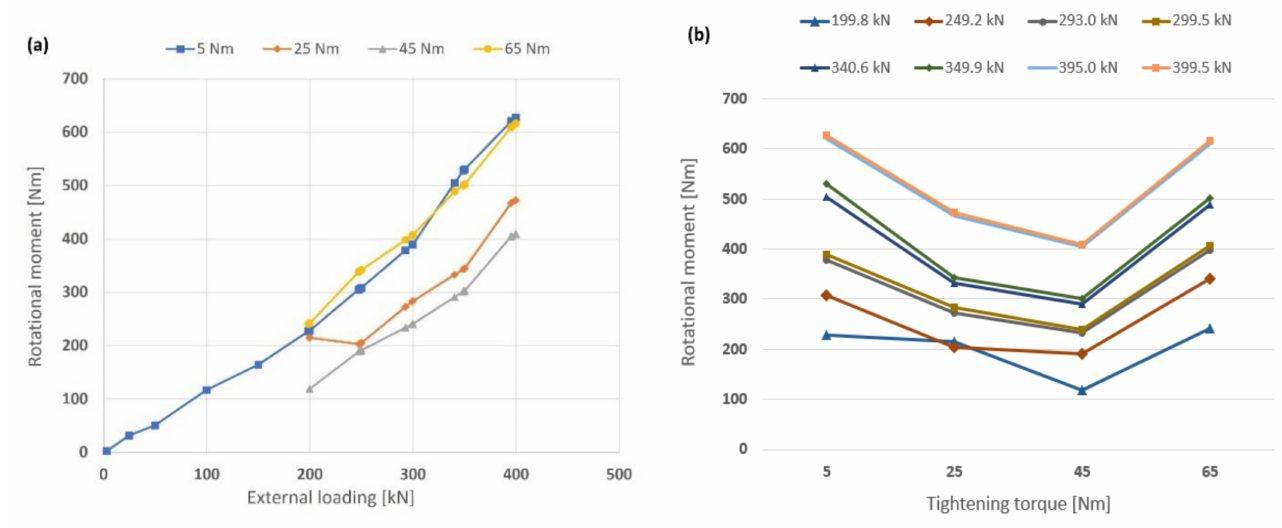
Figure 14. Test 2a—Total rotation moment per bearing, with bearing on single sleeve with ( a ) increasing external load and ( b ) increasing torque